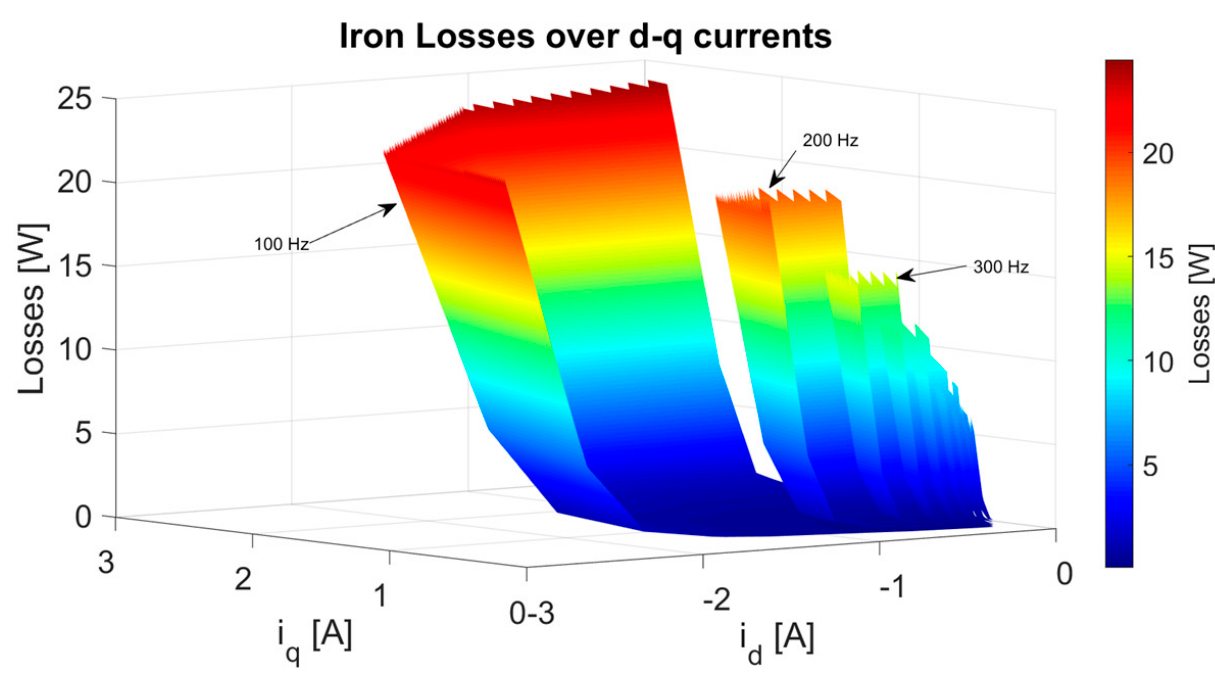
Figure 4. Iron losses map over the d-q currents for each feeding frequency.